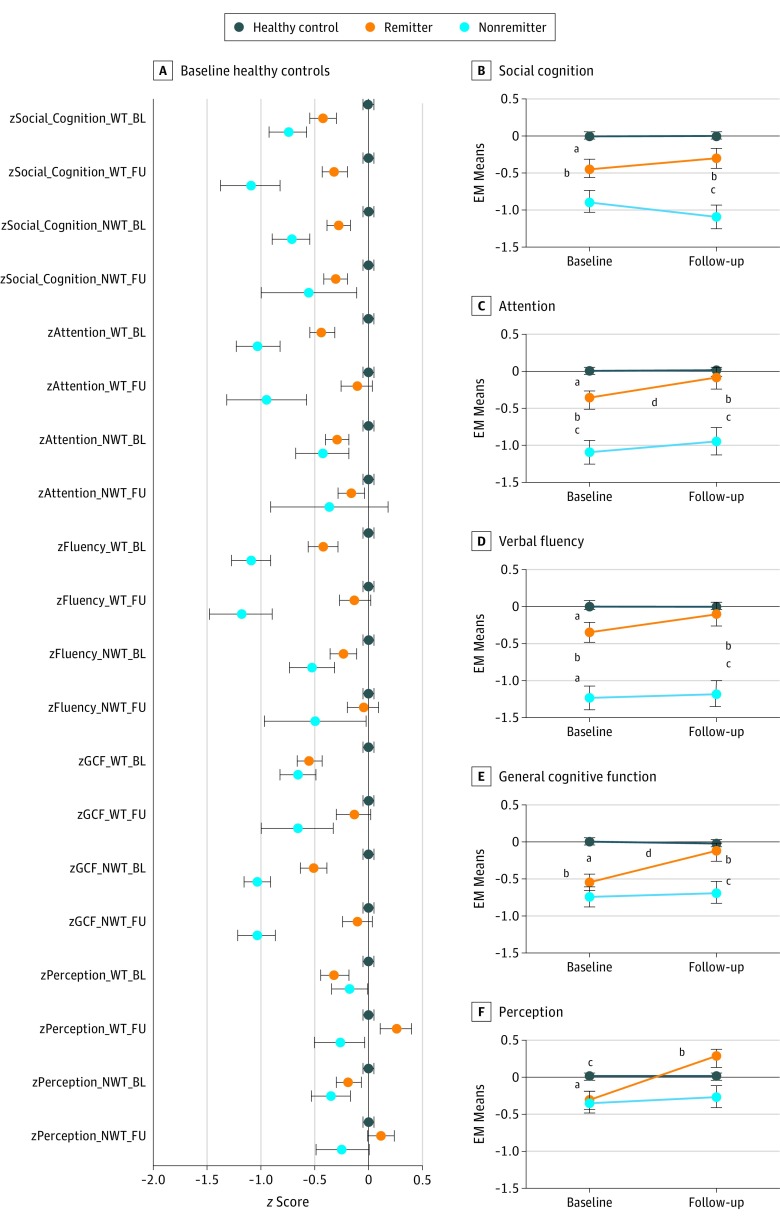
Cognitive Component Profiles by Group and Longitudinal Time by Group
ModelsA, Cognitive component profiles by group. B-F, Longitudinal time by group. BL
indicates baseline; EM, expectation maximization; FU, follow-up; GCF, general
cognitive function; NWT, nonweighted; WT, weighted; z, standardized score.
Bonferroni-corrected model significance is indicated by superscript notation.aHealthy controls vs remitters.bHealthy controls vs nonremitters.cRemitters vs nonremitters.dRemitters baseline vs remitters follow-up.